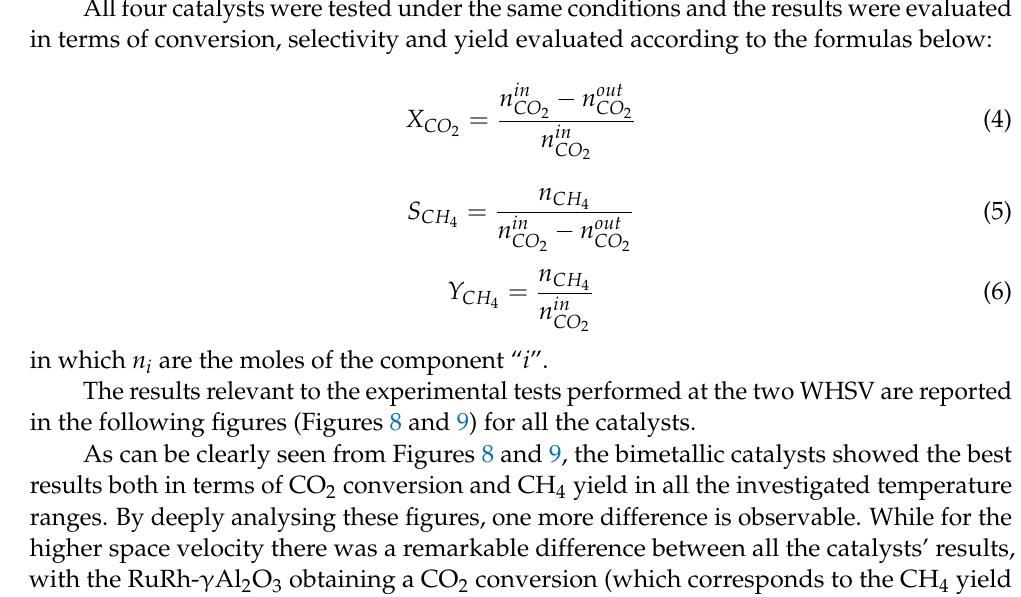
Table 2. Catalysts’ theoretical and experimental H 2 consumption.